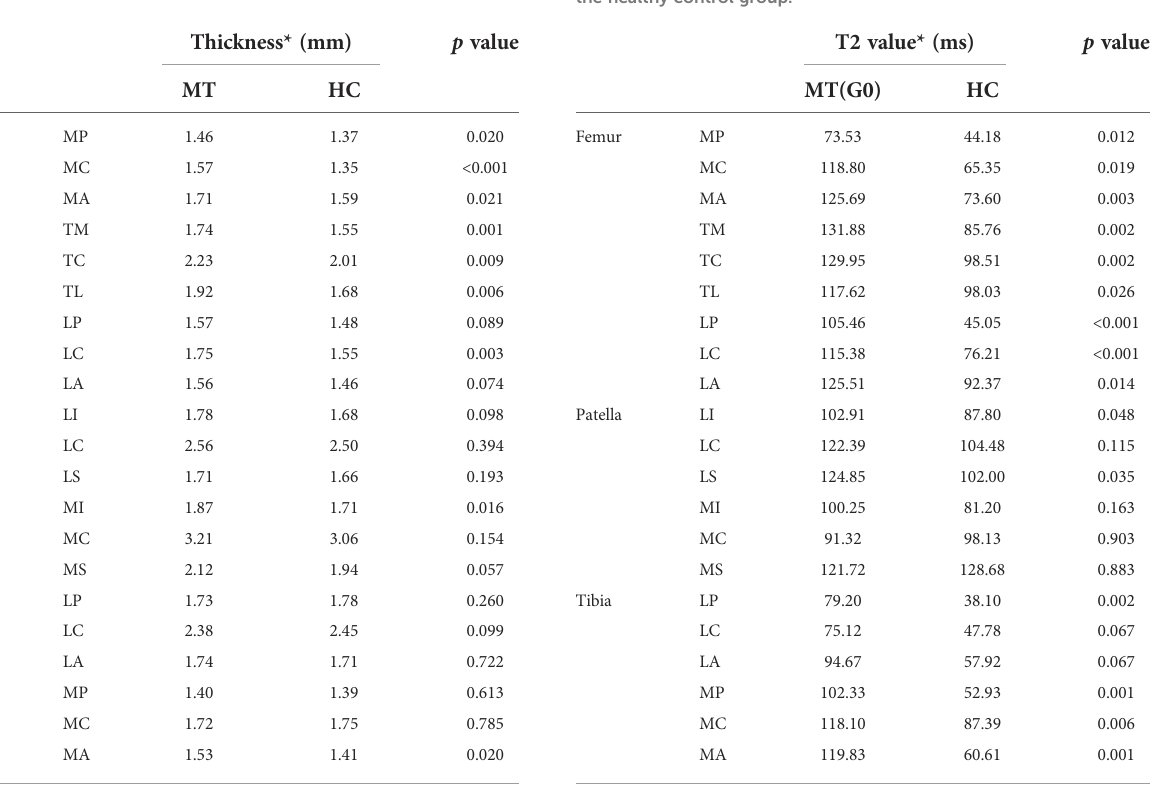
TABLE 4 Comparison of thickness of the articular cartilage 21 subregion between the healthy control group and the meniscus tear group.